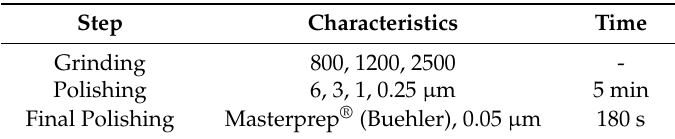
Table 3. Metallographic sample preparation.